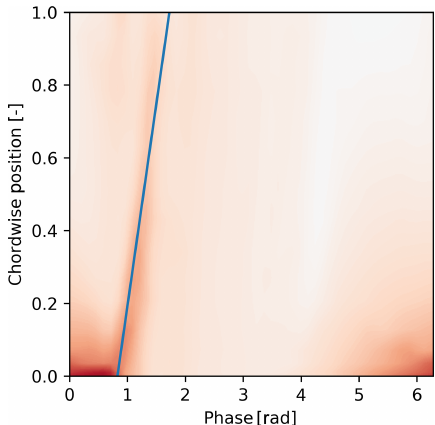
Figure 8. Example CNN output. Color intensity refers to suction pressure, and the blue line is regressed fit. Pressure is standardized; therefore the colors represent Z scores. No units or color bar are provided for this